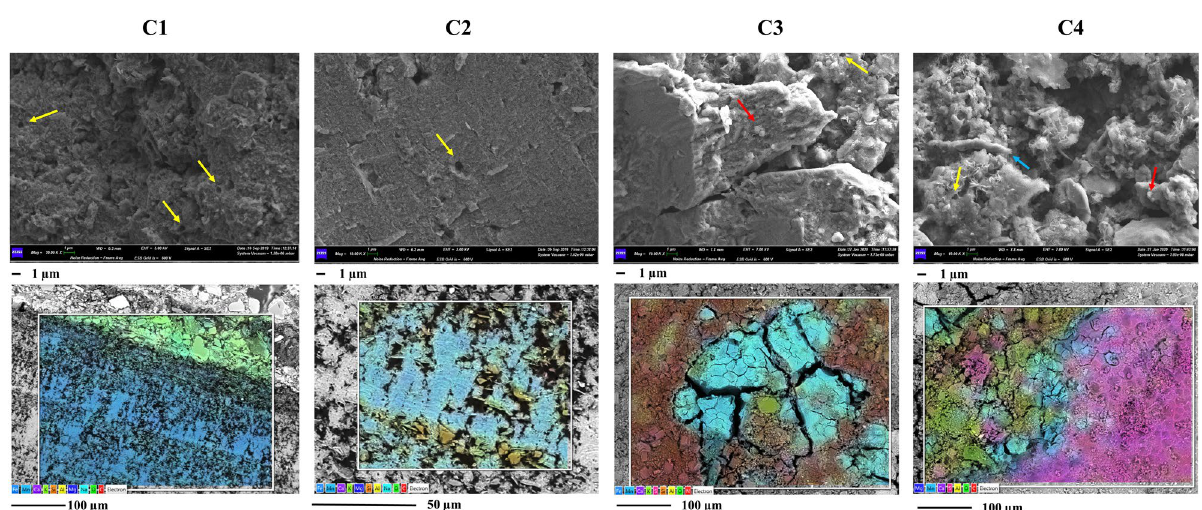
Figure 2. SEM–EDS investigations of cave samples. Upper panels show the micrographs obtained by SEM observations. In the panels the putative microbial imprints are marked by yellow arrows, the microbial biofilms by blue arrows, and microbial mineralized structures by red arrows. Work distance (WD) = 6.2–7.8 mm; electron high tension (EHT) = 5–7 kV; Signal = SE 2 (secondary electrons); Magnitude = 10 K X (Scale bars are presented under each panel). Lower panels present the elemental maps obtained by EDS analyses. The microanalysis acquisitions were carried out at 12.00 kV (Scale bars are presented under each panel). Mn presence is underlined with light blue